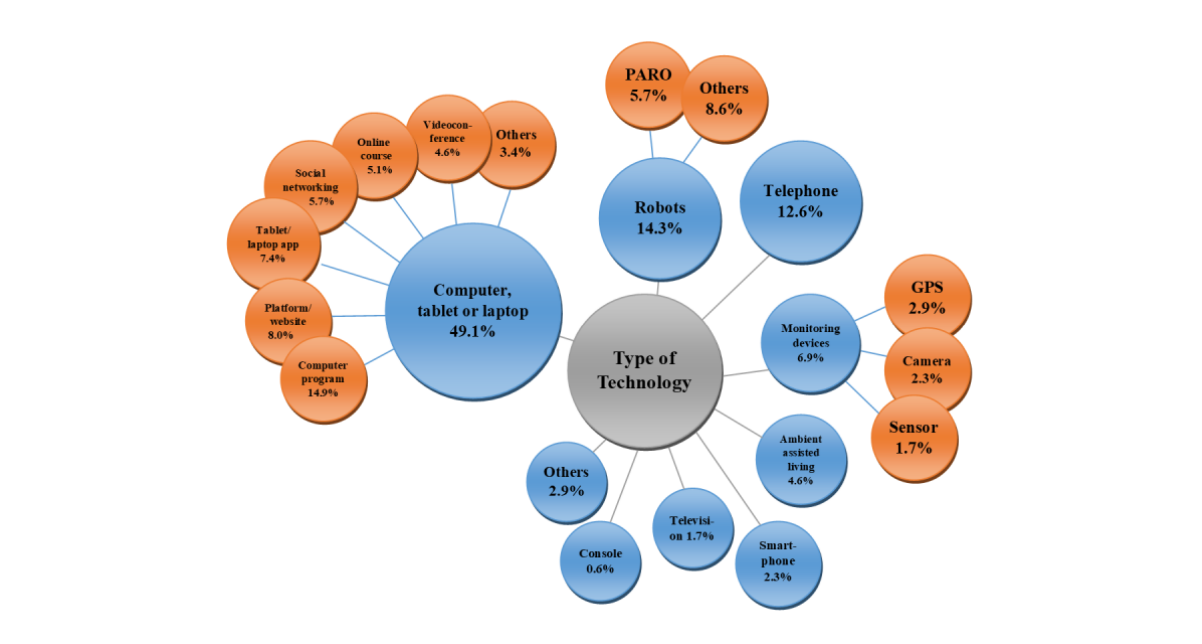
Figure 2. Relative frequencies of the types of technologies in the included studies (n=175).